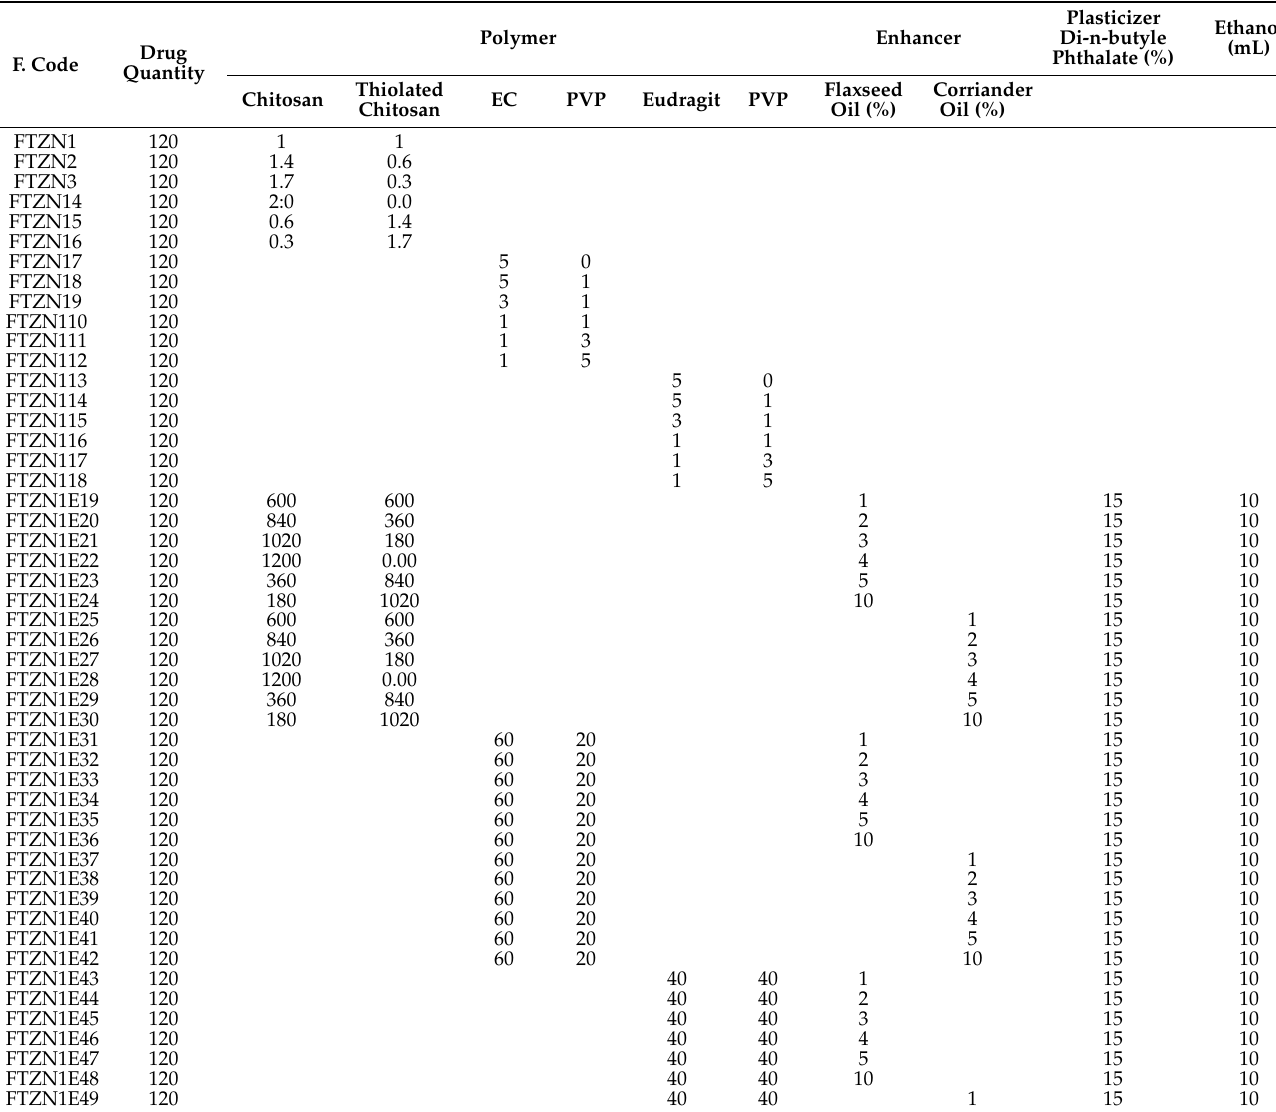
Table A1. Composition of tizanidine with different ratios of chitosan and thiolated chitosan, EC and PVP, eudragit and PVP, with and without permeation